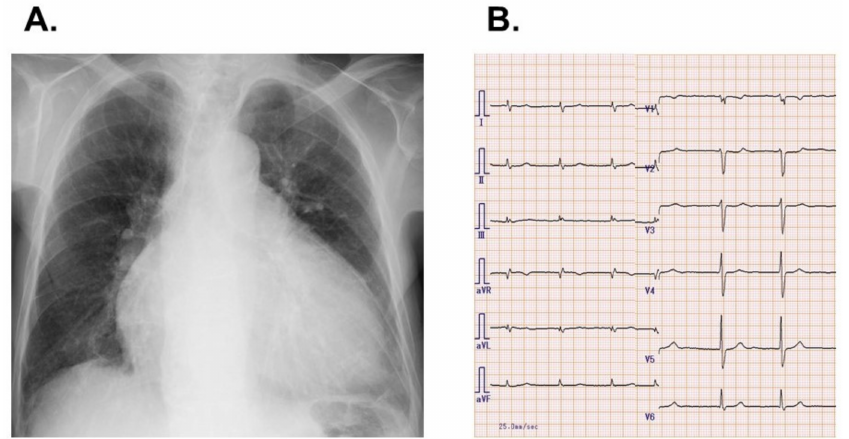
Figure 1. Chest X-ray ( A ) and electrocardiogram ( B ) on admission. Estimated glomerular filtration ratio was 24 mL/min/1.73 m 2 with no proteinuria. Plasma B-type natriuretic peptide was 578 pg/mL. Hemoglobin was 7.4 g/dL. Erythro- poietin was 65.2 mIU/mL, ferritin was 35 ng/mL, transferrin saturation was 10.4%, and reticulocyte was 0.4%.